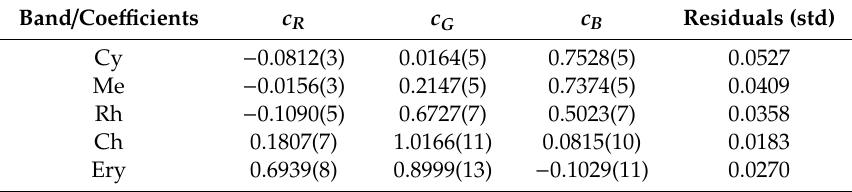
Table 1. Optimum fitting coe ffi cients 1 of Y = c R R + c G G + c B B for the five human photoreceptors. Band / Coe ffi